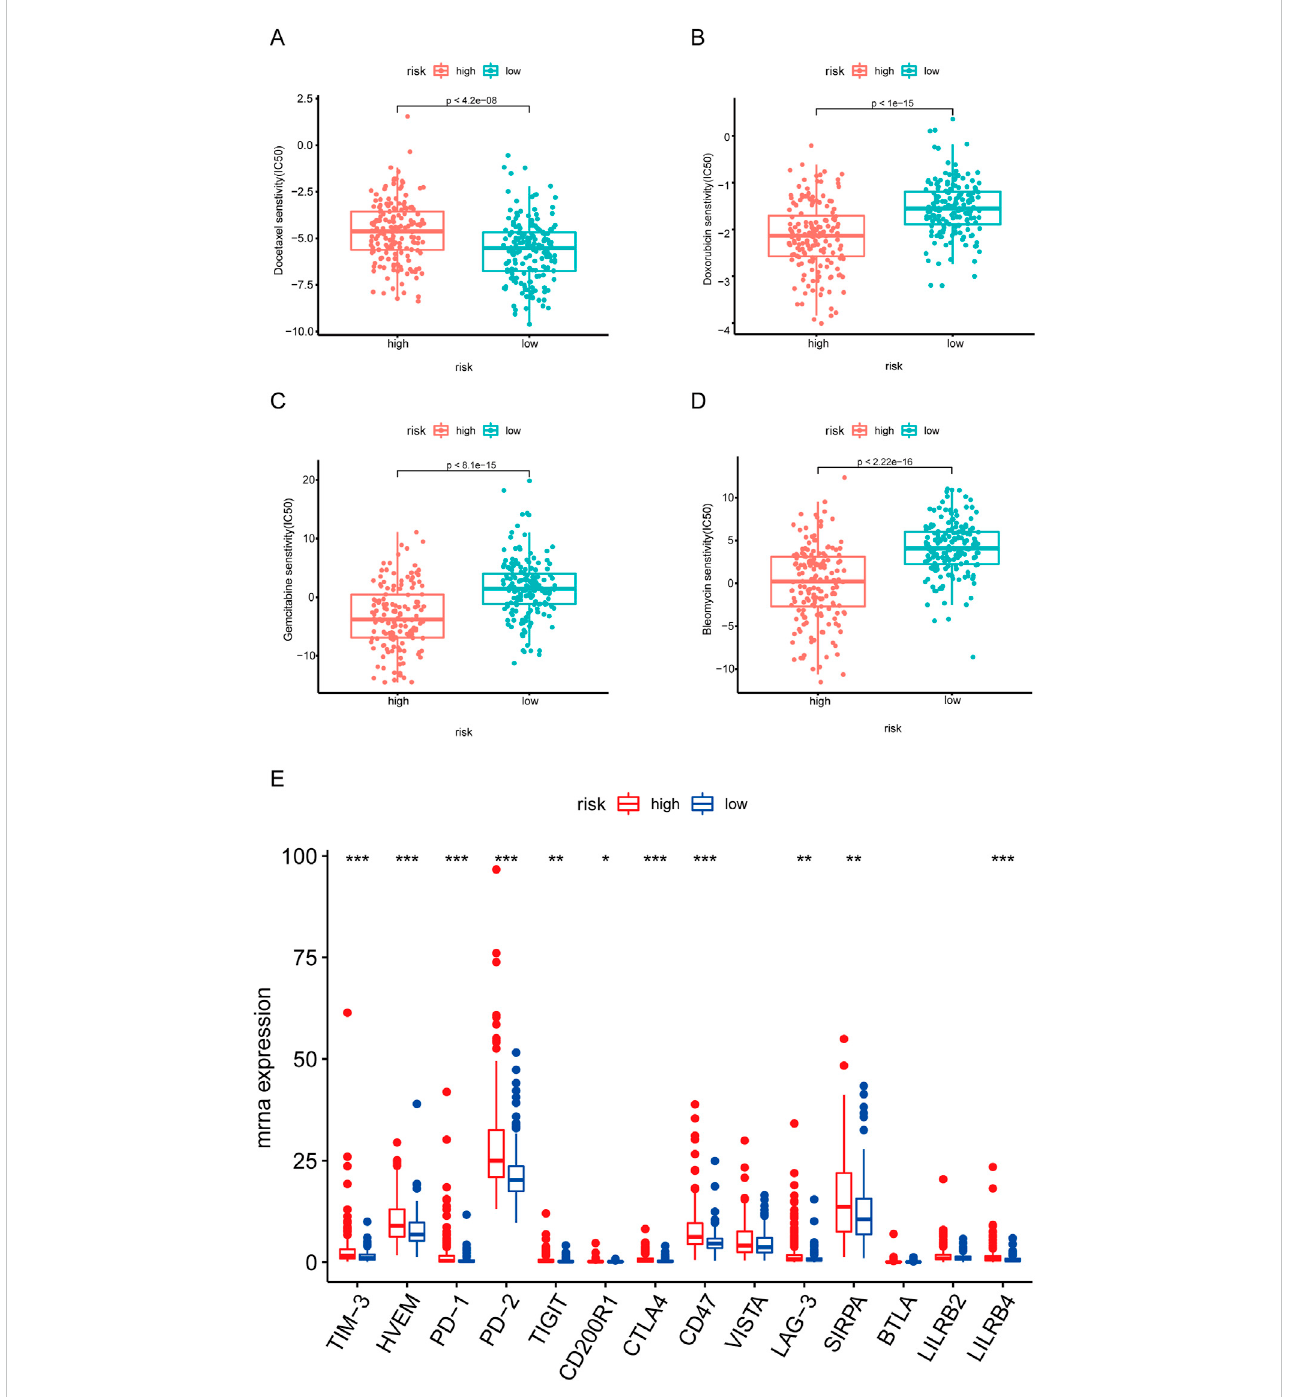
Correlationofriskscorewithimmunotherapy. (A – D) BoxplotofthedifferencesinIC50ofdocetaxel,doxorubicin,gemcitabine,andbleomycinbetween high- and low-risk groups. (E) Box plot of the differences in immune checkpoint between high- and low-risk groups. * p < .05. ** p < .01. *** p <